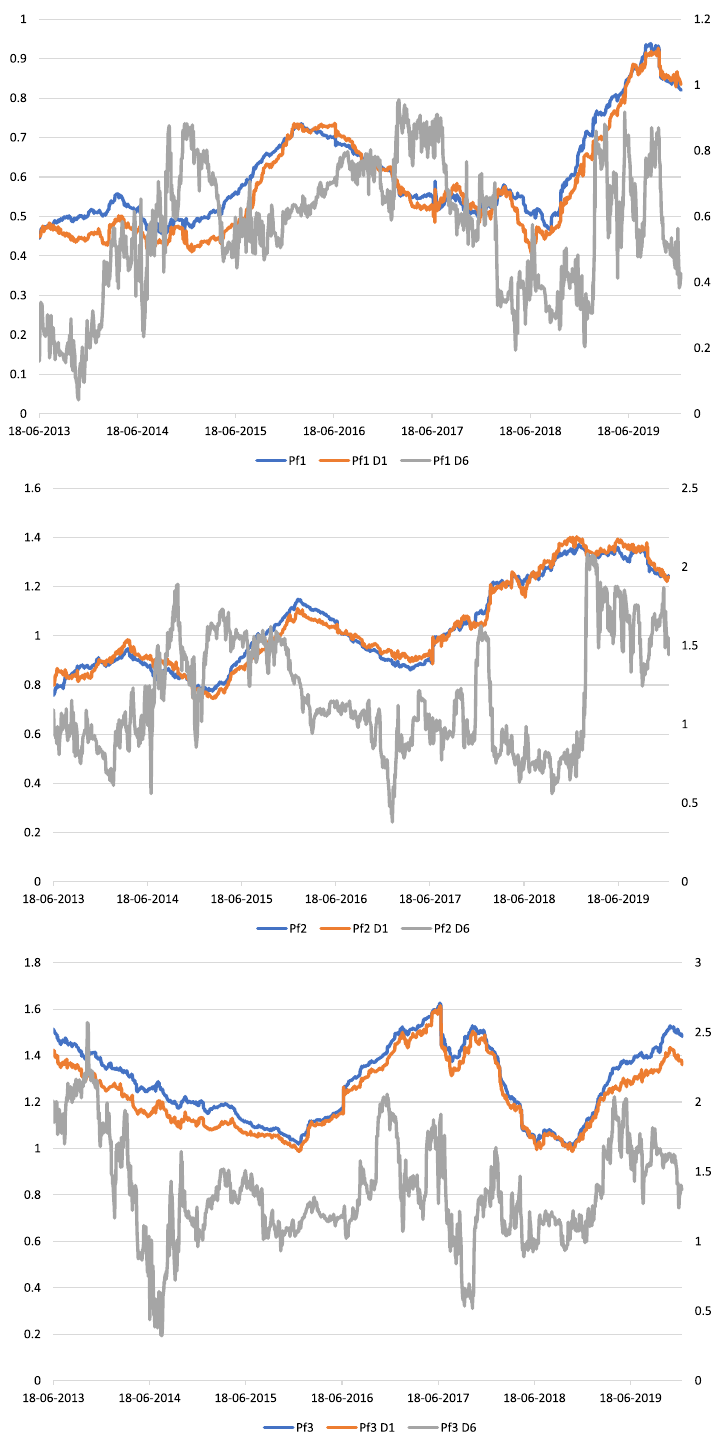
Fig. 1 Time–frequency-varying betas of